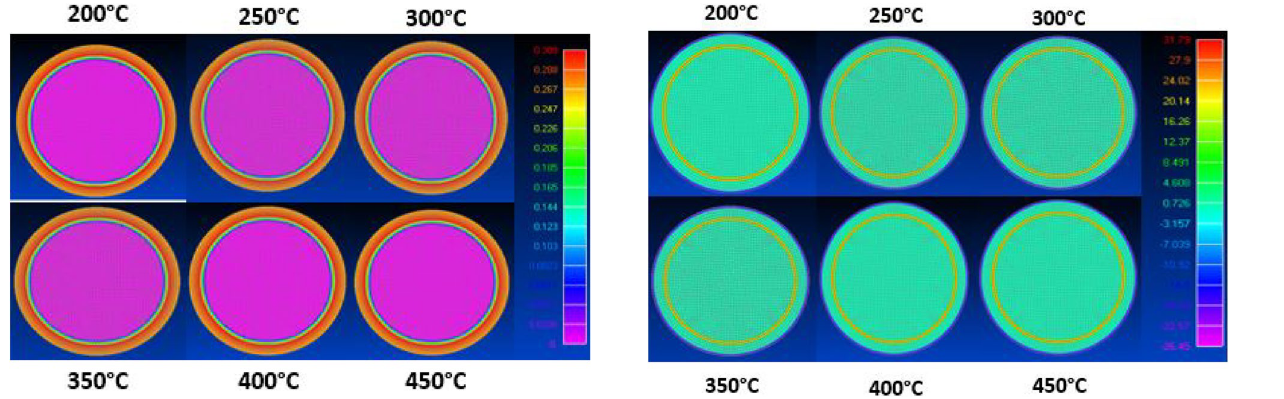
Fig. 8 Thermally constrained load at different steady-state thermal regimes (for the view of figures with labels and coordinates, a reader is advised to see Online Appendix